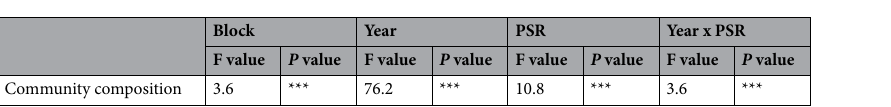
Table 2. Results of permutational multivariate analysis of variance (PERMANOVA, based on Bray–Curtis dissimilarity) testing the effects of plant species richness (PSR) and its changing effect over time on the carabid community composition, based on the Bray–Curtis dissimilarity. Asterisks mark the level of significance (‘***’ < 0.001).